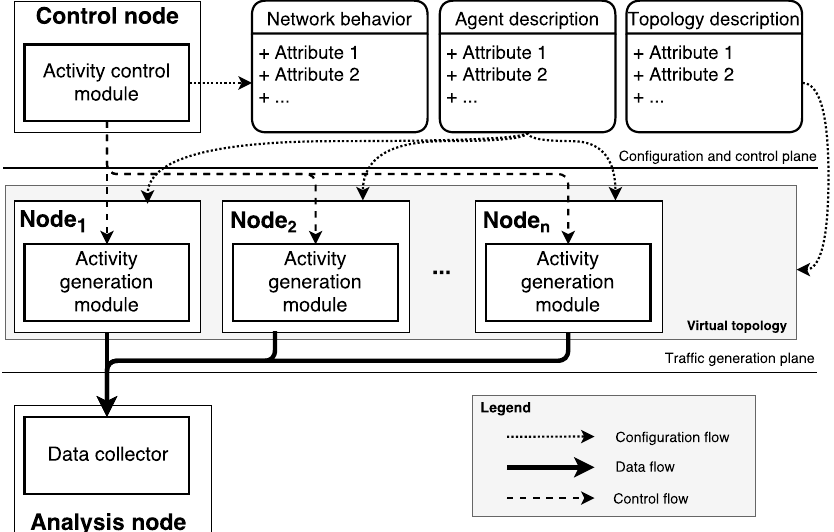
Figure 1. Diagram of the architecture of our